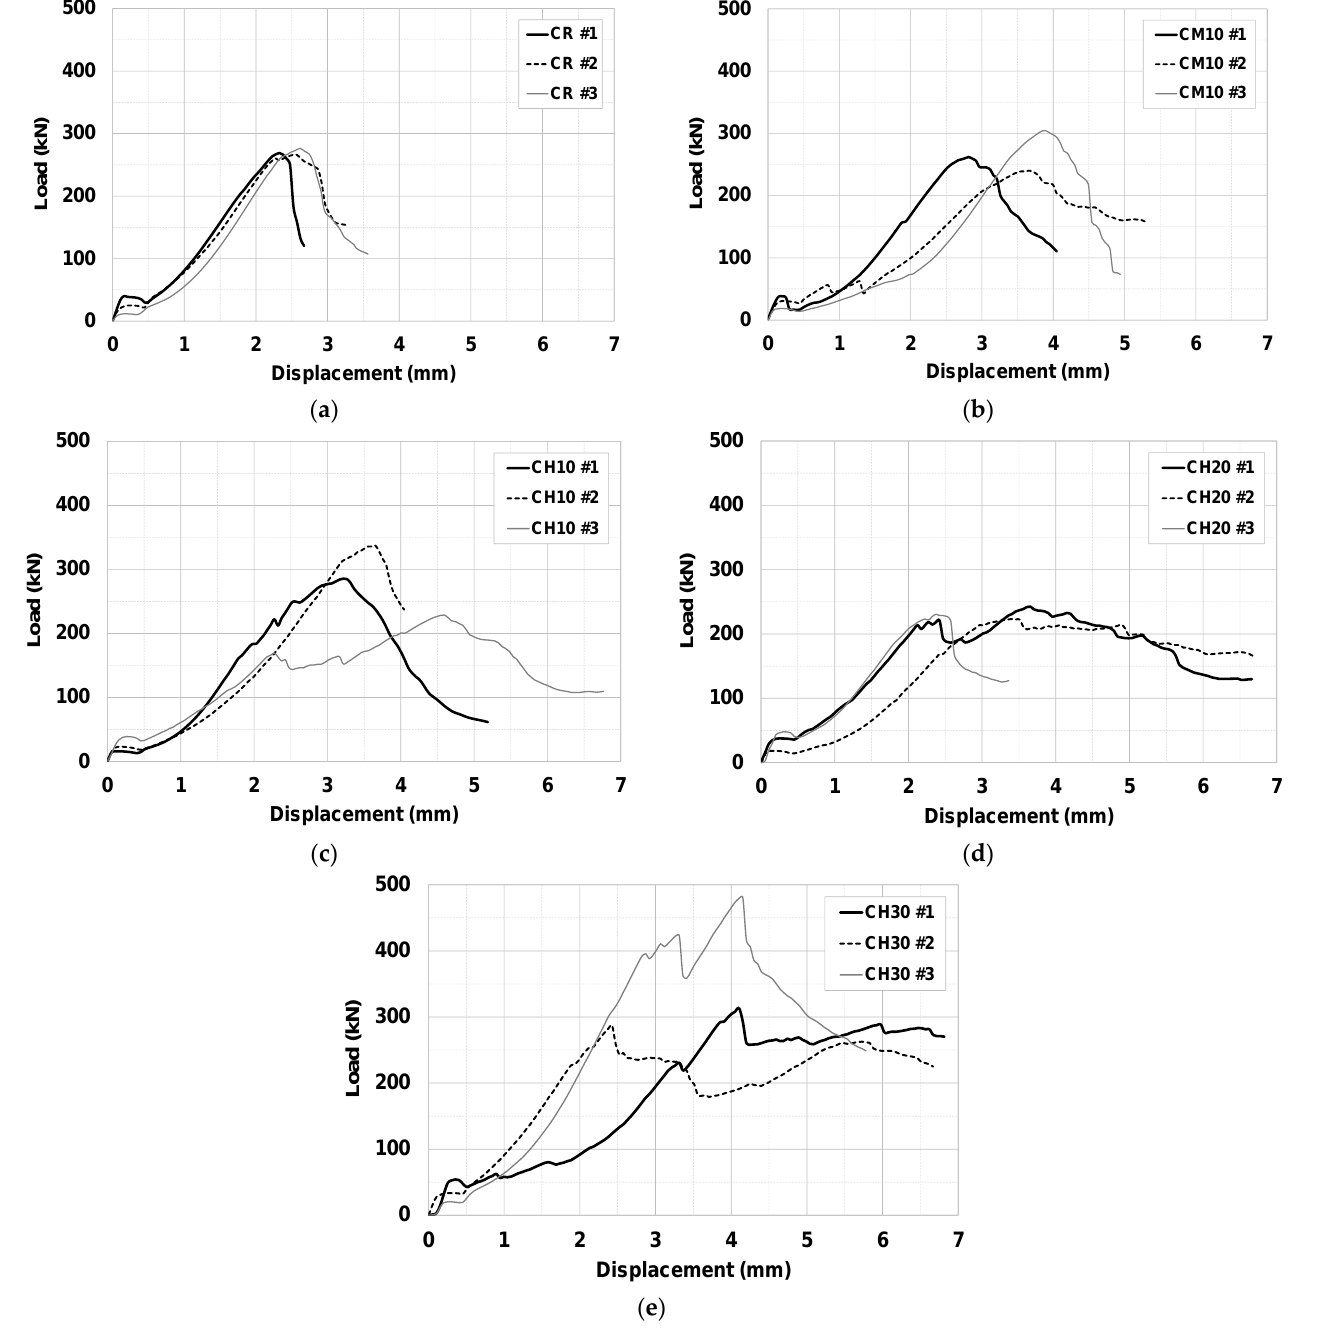
Figure 5. Load – displacement response of compressive strength test: ( a ) CR; ( b ) CM10; ( c ) CH10; ( d ) CH20; ( e ) CH30.